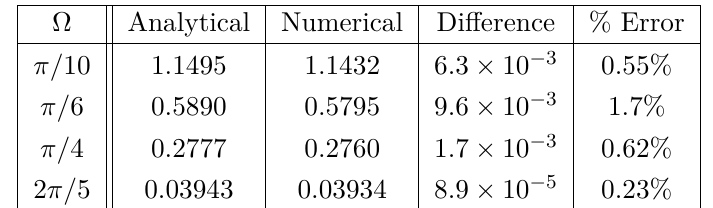
Figure 2. Left: Profile of the region described in section 2.2 with Ω ≈ 0 . 85 . The full 3D entangling region is formed by rotating the curve around the red vertical line. Right: The minimal surface z ( r, x ) in the bulk, as computed by the Surface Evolver, with the holographic coordinate z pointing upwards.